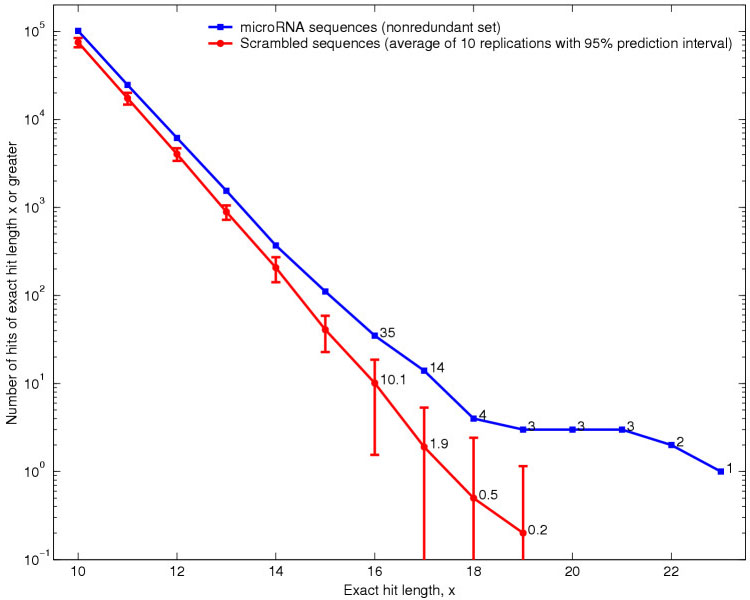
microRNAs and their scrambled counterparts interact differently with the population of human mRNAs. Shown are all exact hits ≥ 10 bases long (not counting G:U matches) produced on human RefSeq mRNAs by the set of nonredundant microRNAs, vs. the average of 10 replications of scrambled control sequences. Shown is the number of hits as a function of exact hit length. Only the longest hit was counted: e.g., for a hit of length 18, the two subsets of length 17 in the same hit position were not counted.